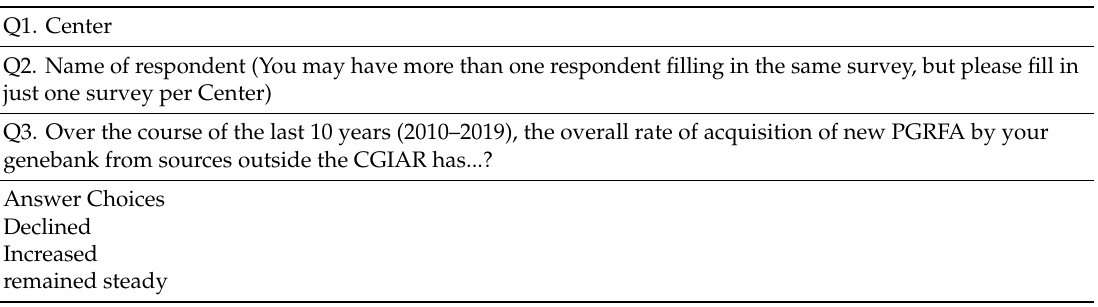
Table A1. Survey on Acquisitions and